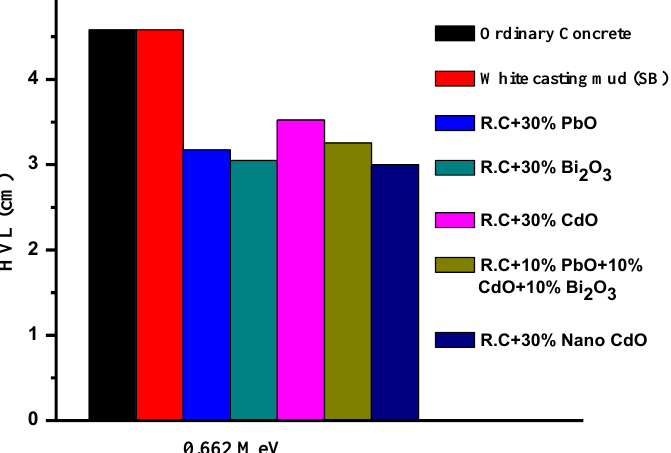
Figure 7. The HVL of the studied materials compared with ordinary concrete and white casting mud.